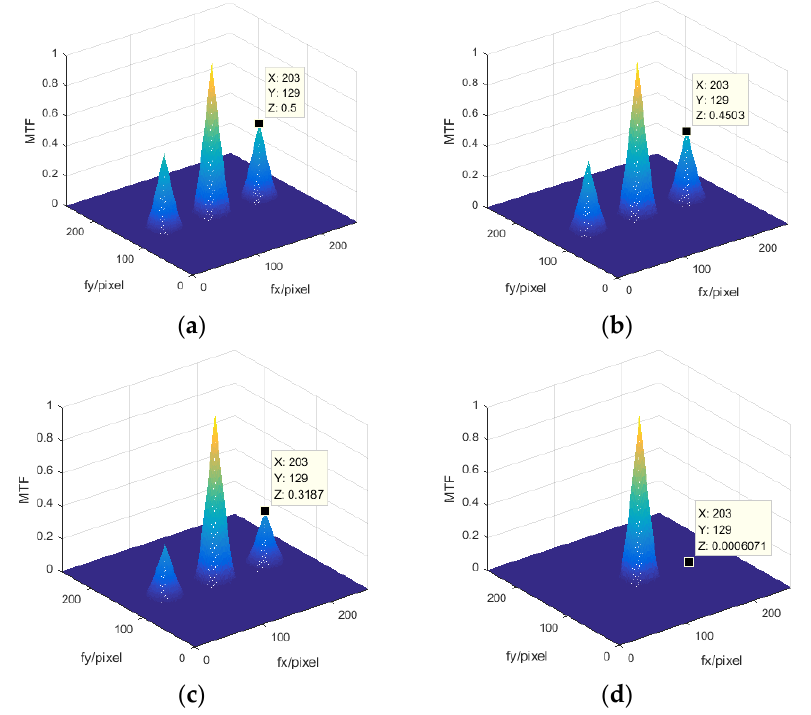
Figure 2. Modulation transfer function (MTF) of four different piston errors obtained by MATLAB simulation. ( a ) Piston error = 0 μm, ( b ) piston error = 50 μm, ( c ) piston error = 100 μm, ( d ) piston error = 200 μm.